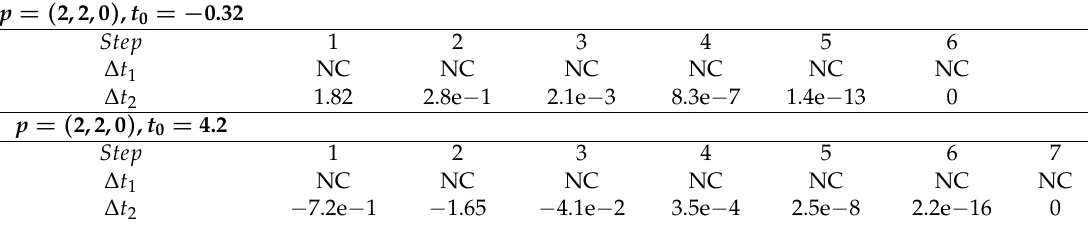
Table 2. Stepsizes ∆ t 1 , ∆ t 2 in Example 2 for the Newton’s method and our second-order